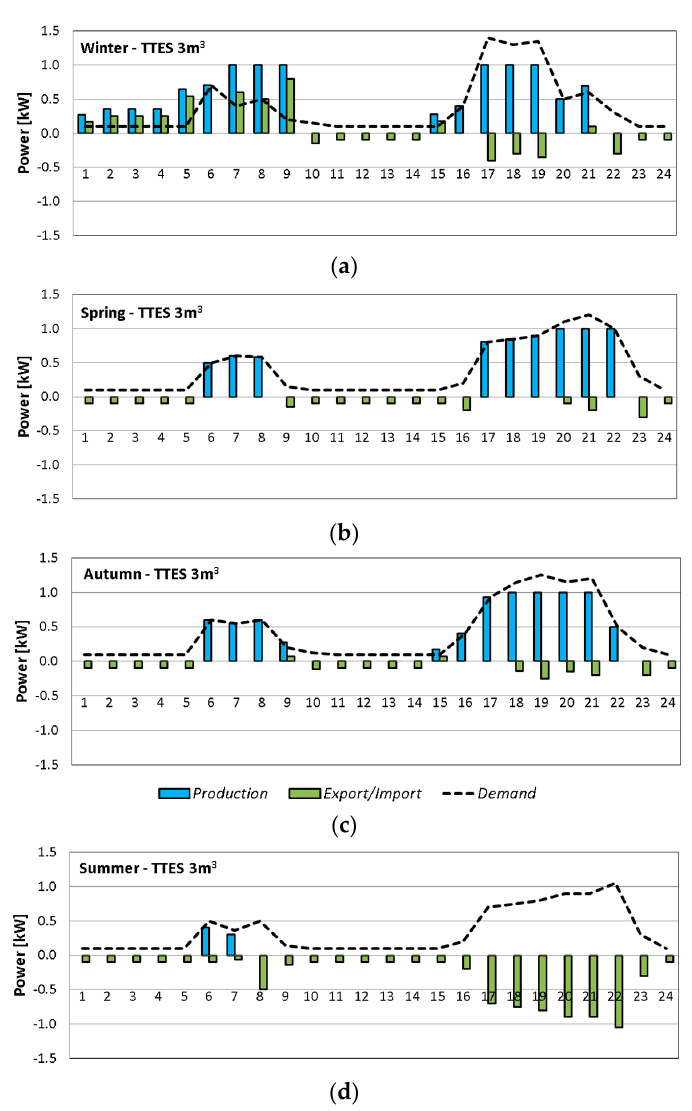
Figure 9. Comparison of the electricity demand and production in the mCHP system that used the new algorithm for each representative day of ( a ) winter, ( b ) spring, ( c ) autumn, and ( d ) summer.